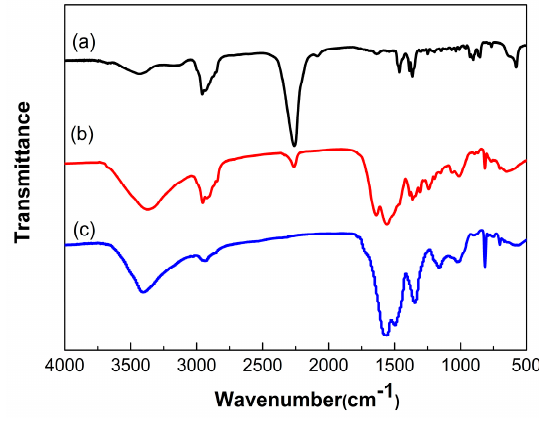
Figure 5. FTIR spectra of ( a ) IPDI; ( b ) microencapsulated IPDI and ( c ) MF shell.